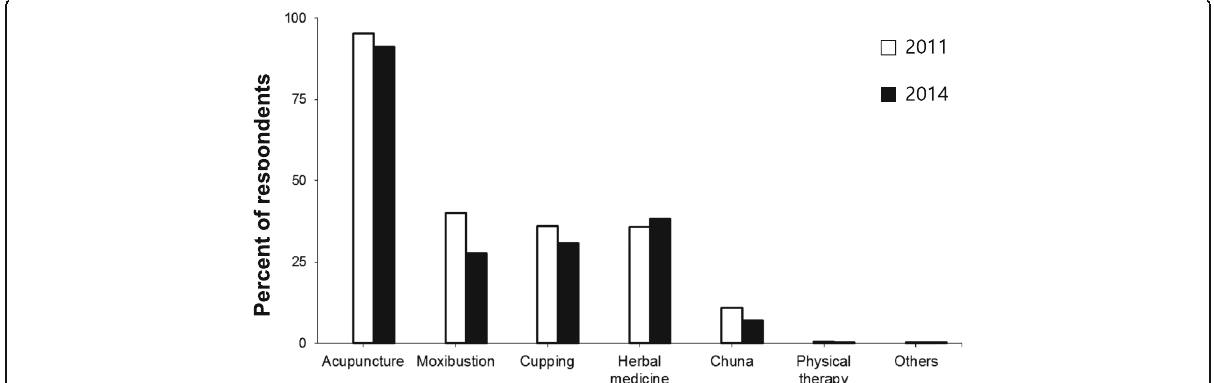
Fig. 3 Changes in the usage of KM therapies between 2011 and 2014. The graph shows the changes over time in the patterns of various therapies received in KM clinics. The 2011 survey data were obtained from Woo et al.